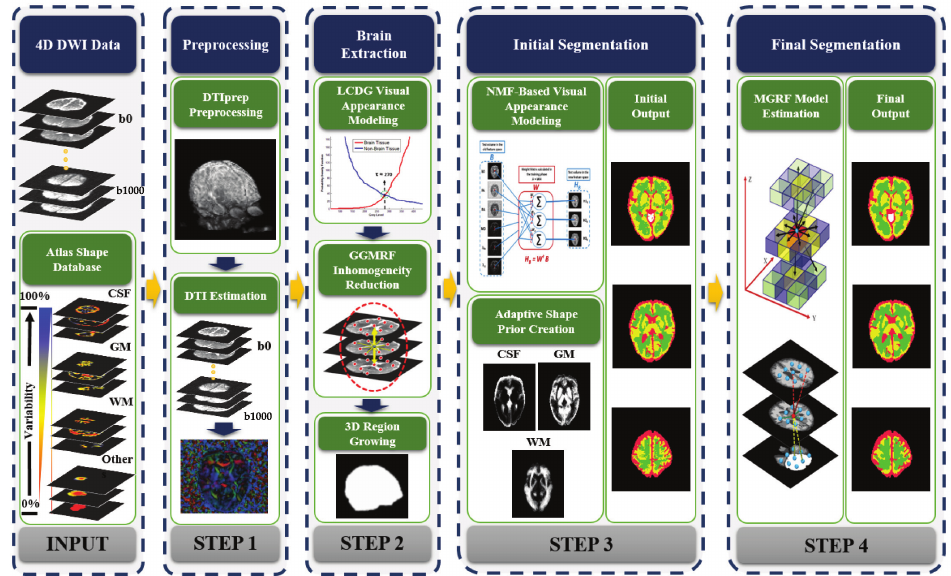
Figure 1. The basic steps of the proposed framework for segmenting different structures from infant DTI brain